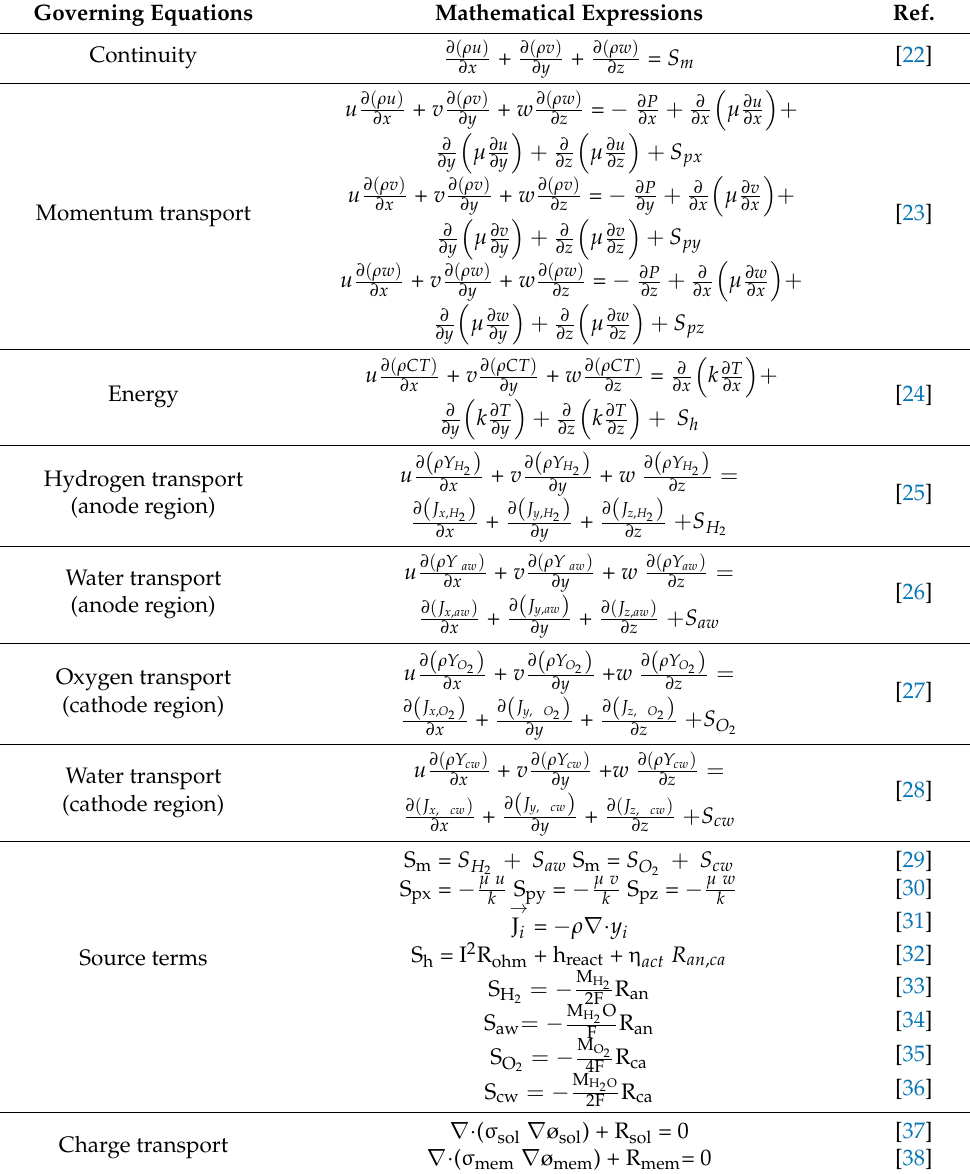
Table 3. A summary of the fuel cell model governing